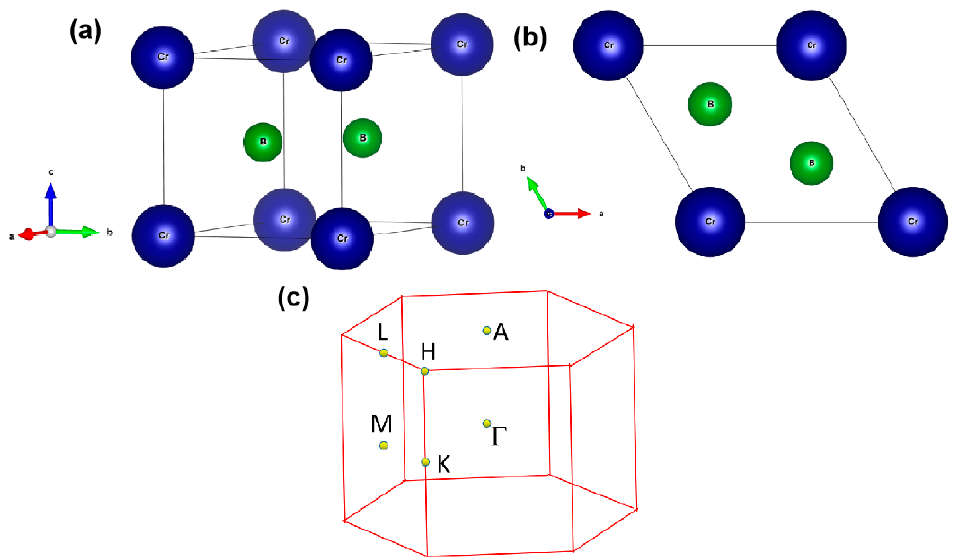
Figure 1. ( a , b ) Structural models of P6/mmm CrB 2 from different viewpoints and ( c ) the bulk Brillouin zone of CrB 2 .